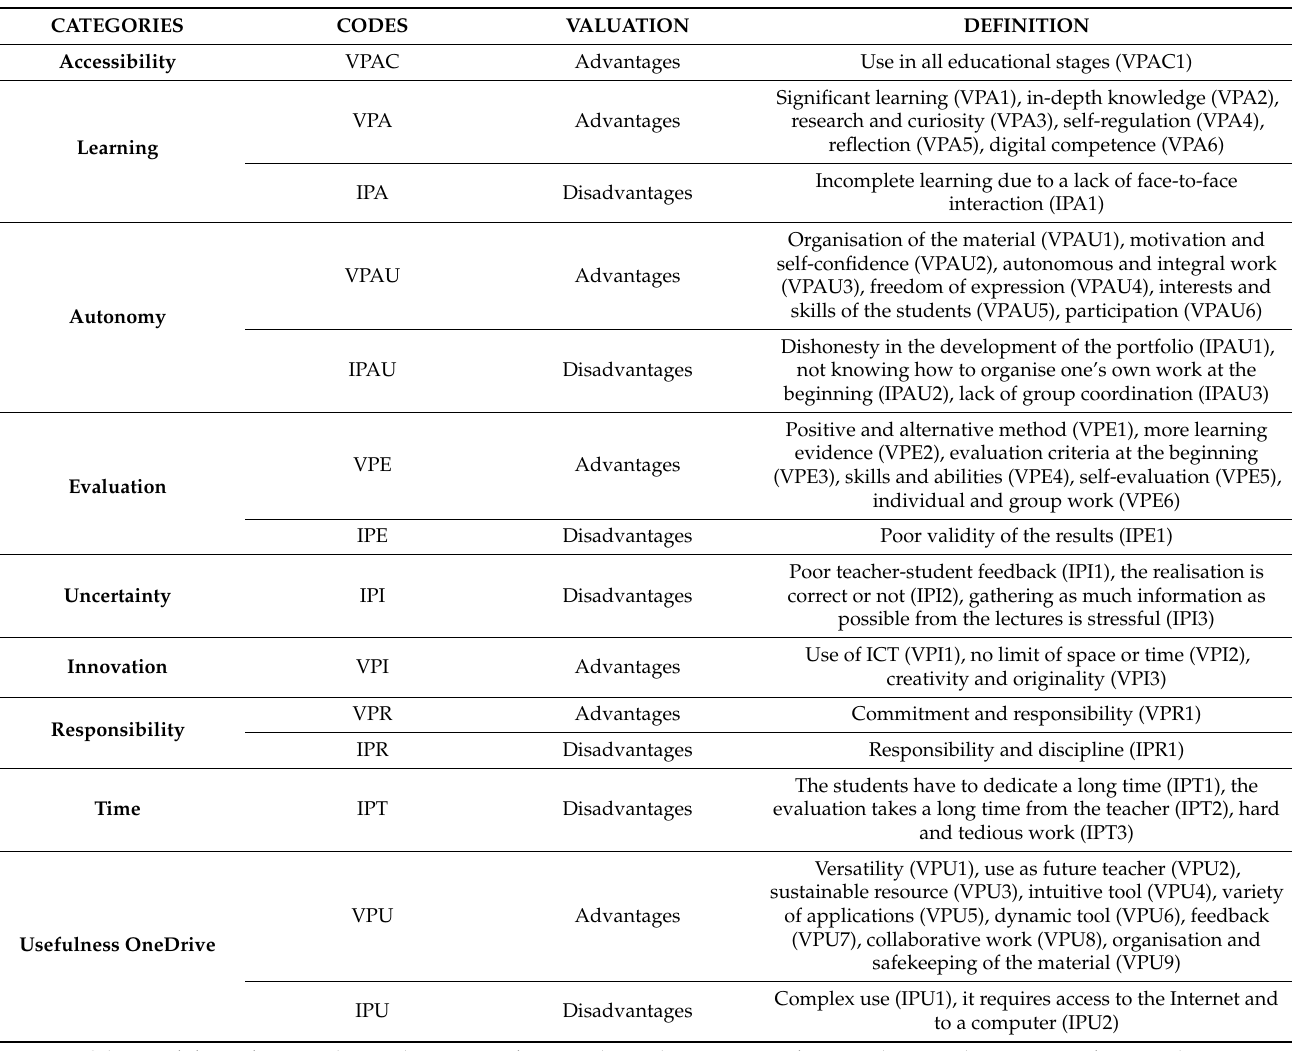
Table 1. Analysis of the advantages and disadvantages of the portfolio according to the perceptions of the